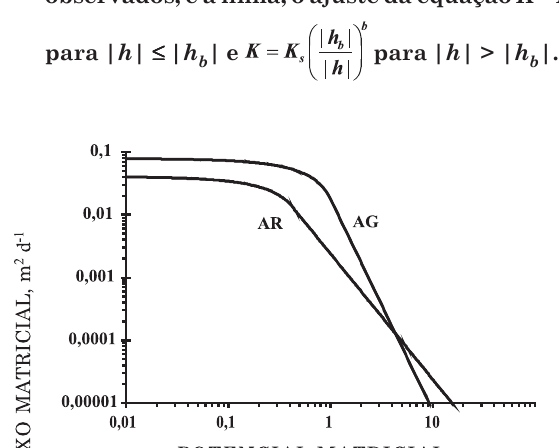
experimento.Figura 4. Condutividade hidráulica em função do potencial matricial nos solos arenoso (AR) e argiloso (AG). Pontos representam os valores observados, e a linha, o ajuste da equação K = K